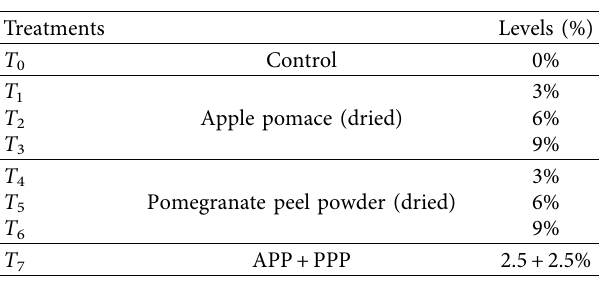
Table 2: Treatment table.